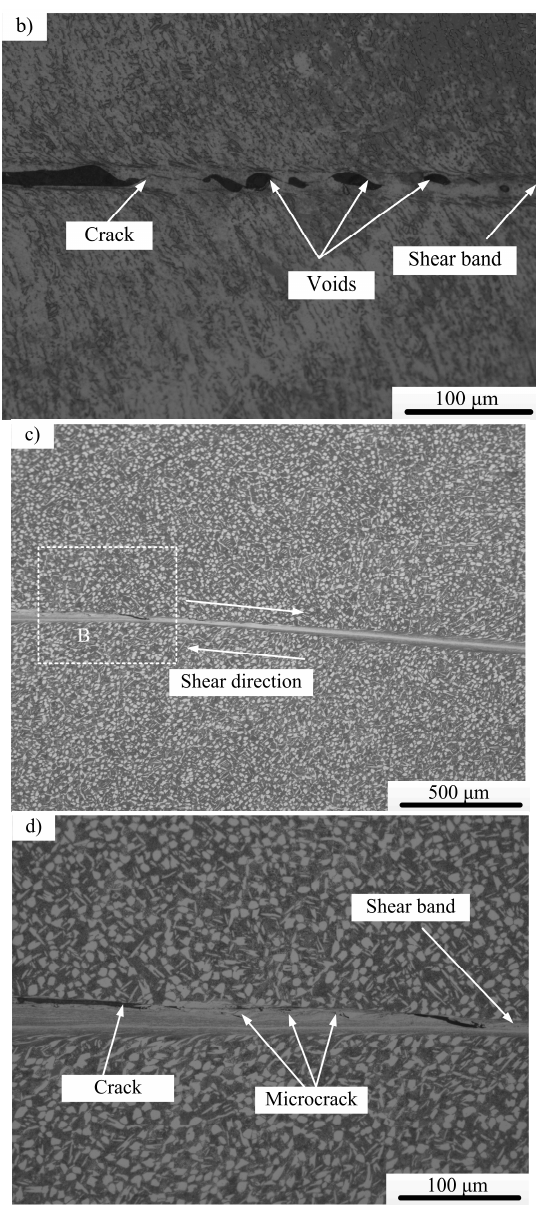
Figure 13. Typical microstructural of ( a ) Ti-64 alloy; ( b ) higher magnification of A in (a); ( c ) Ti-55511 alloy and ( d ) higher magnification of B in (c).